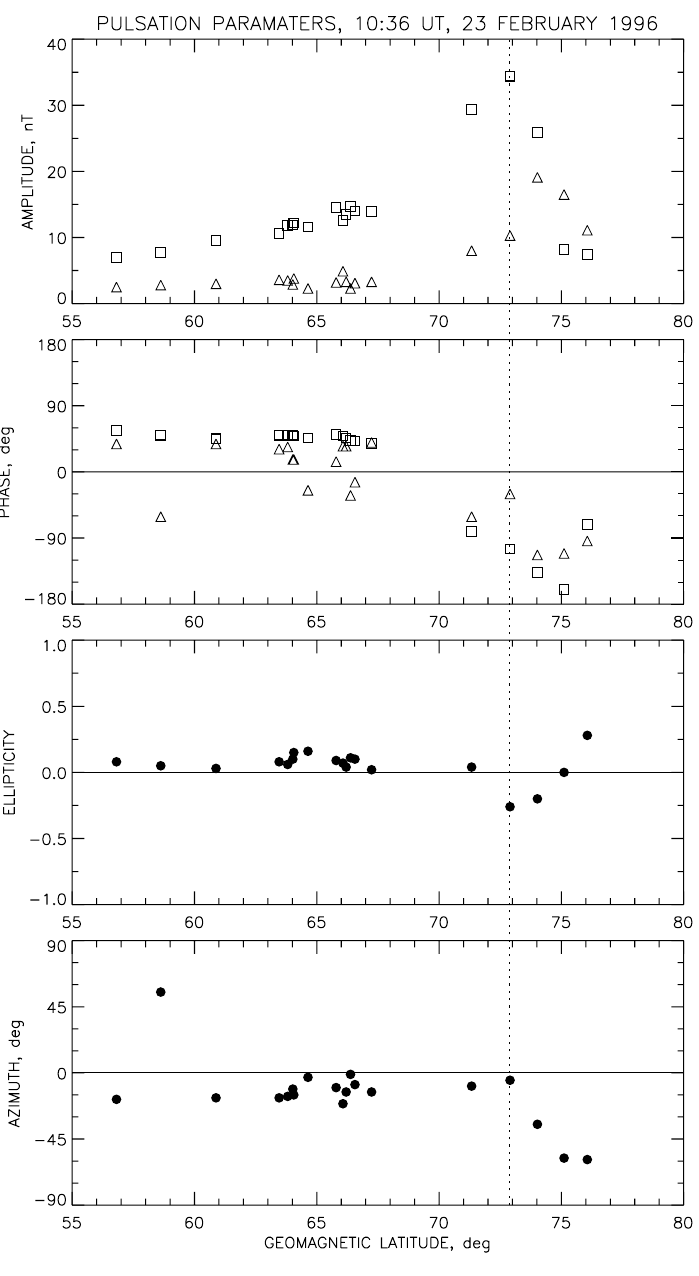
Fig. 7. Variation in amplitude (top panel), phase, ellipticity and azimuth angle (bottom) for 1.6mHz geo- magnetic pulsations at 10:36UT on 23 February 1996. In the upper two panels squares denote H -component values and triangles D